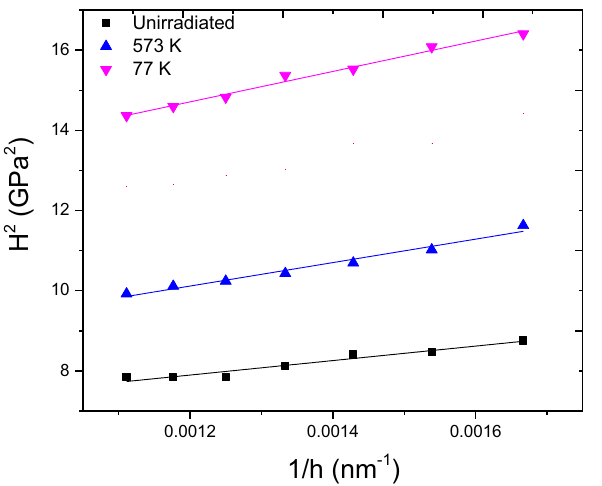
Figure 16. Nix-Gao plot of nanohardness for samples irradiated to 0.2 dpa at 77 K and 573 K